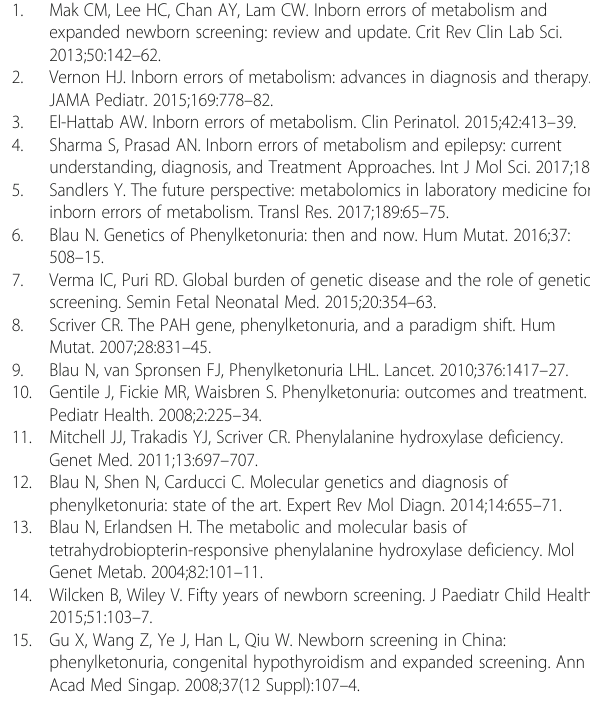
DNA samples. (TIF 7581